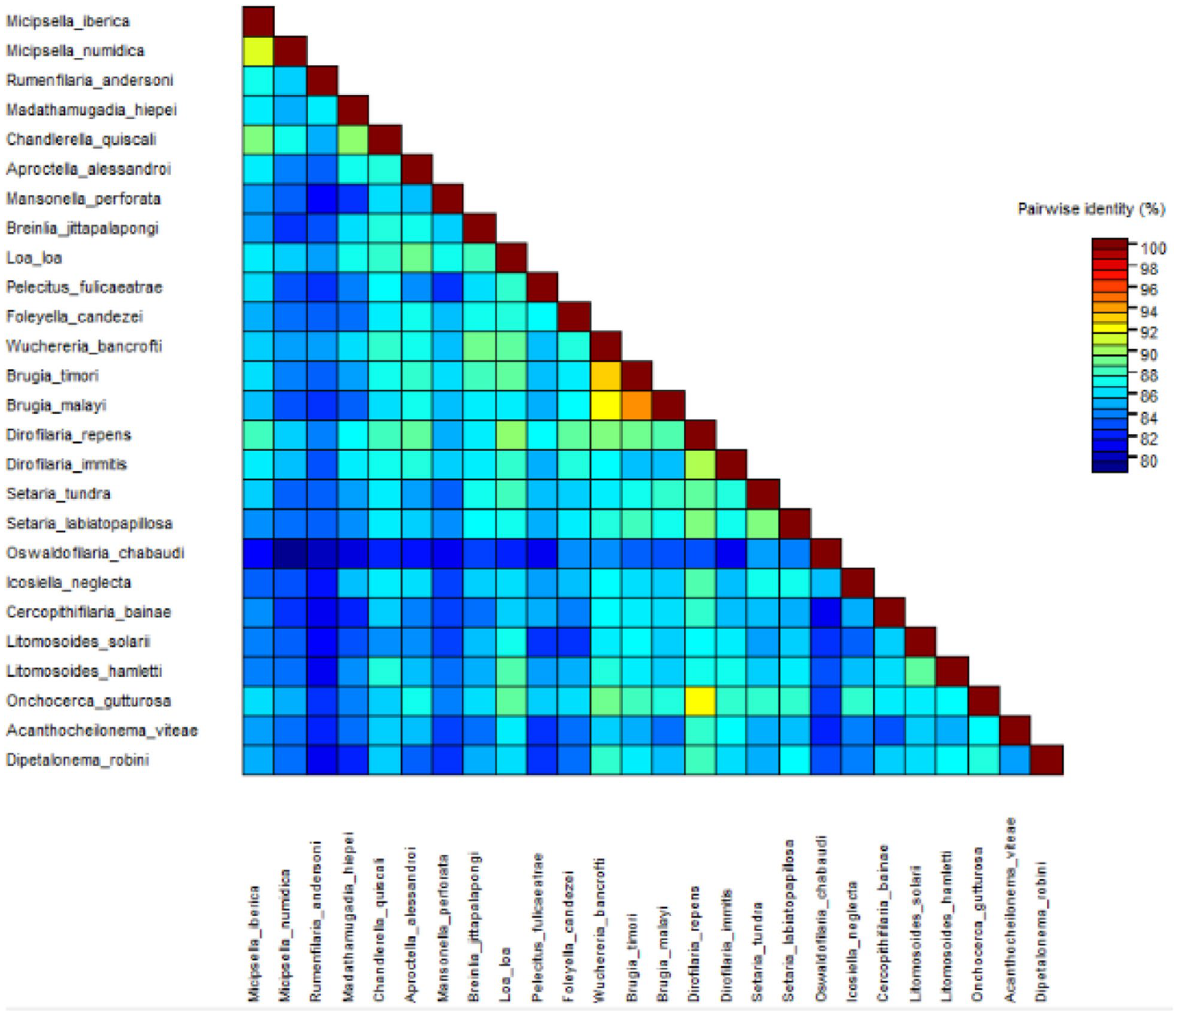
Figure 9. Heat map of nucleotide identity using concatenated partial DNA sequences from 12S rDNA and coxI